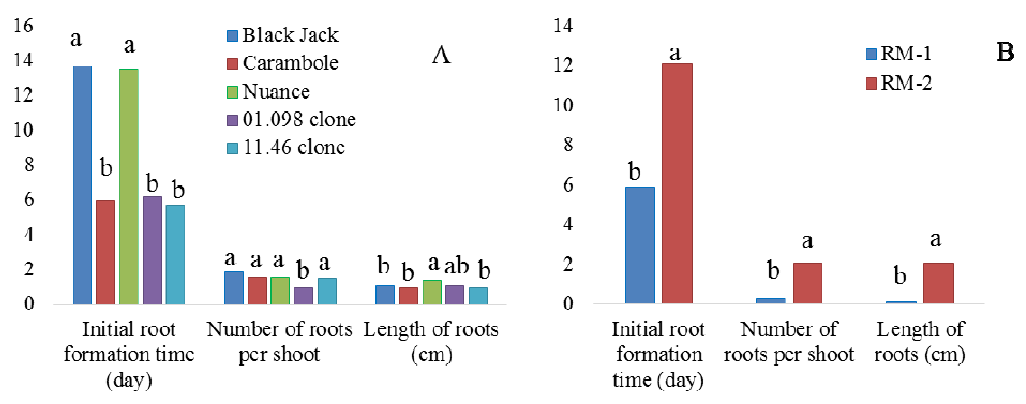
Fig. 6. Responses of Gerbera varieties-clones and rooting media on root initiation and formation. A. Responses of Gerbera varieties-clones on root initiation and formation, B. Effect of rooting media on root initiation and